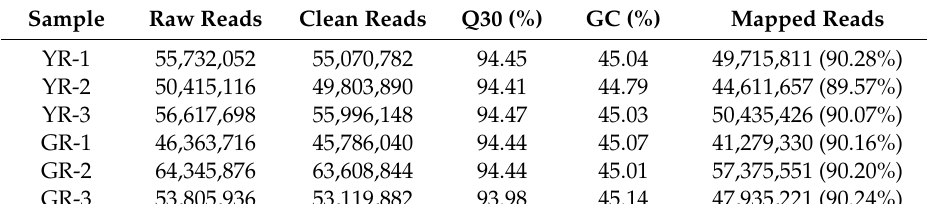
Table 1. The quality of the transcriptomes.